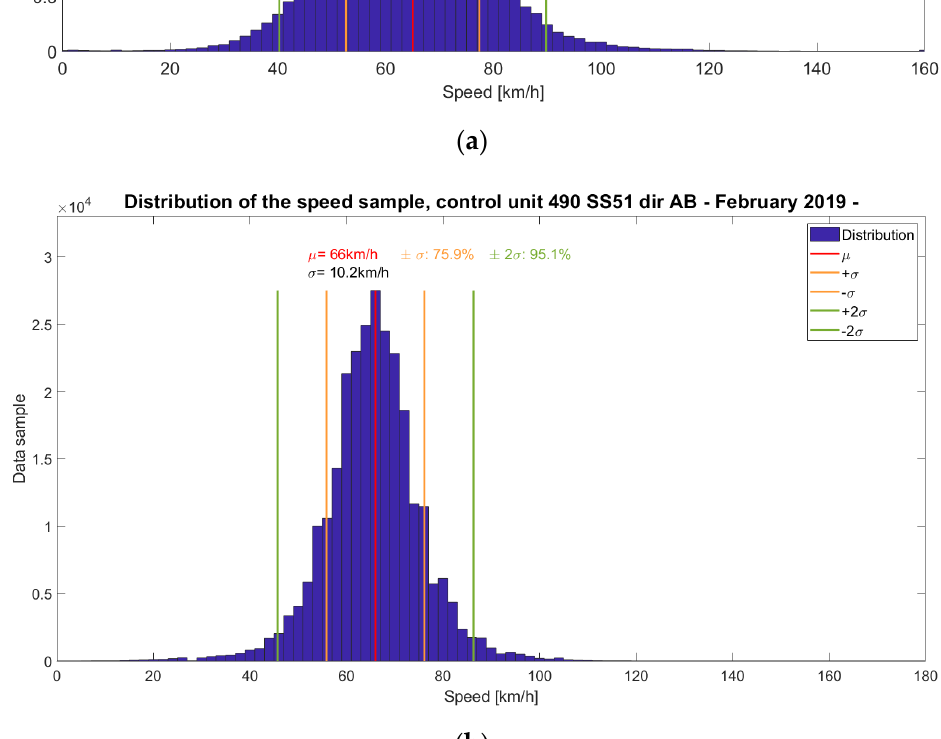
Figure 2. Control units’ speed samples’ distributions: ( a ) Control unit 1333, AB direction, August 2018; ( b ) Control unit 490, AB direction, February 2019.